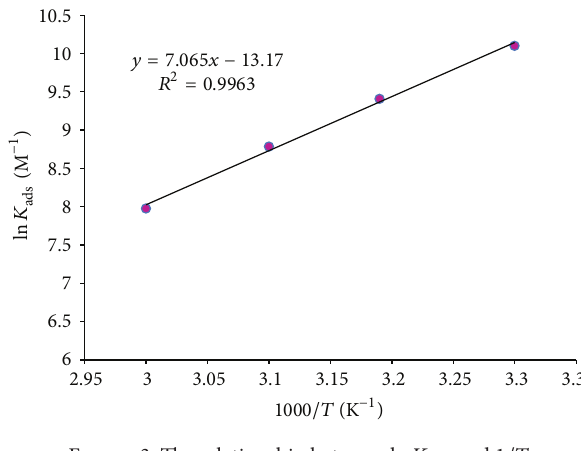
Figure 3: The relationship between ln 𝐾